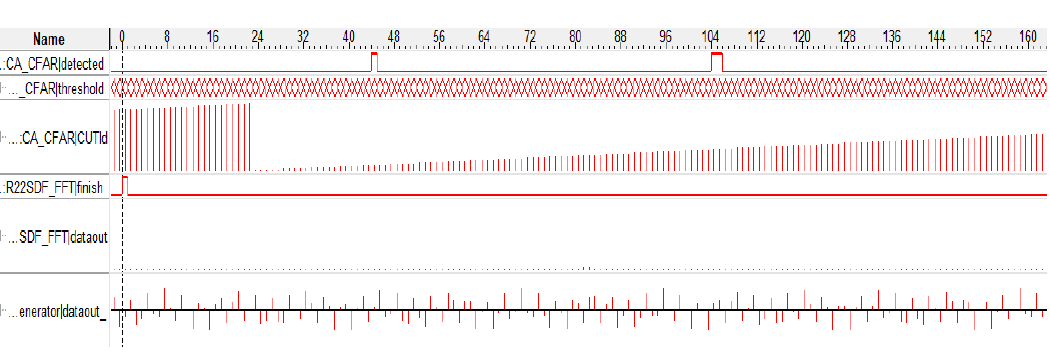
Figure 11. Threshold detection Modelsim results.